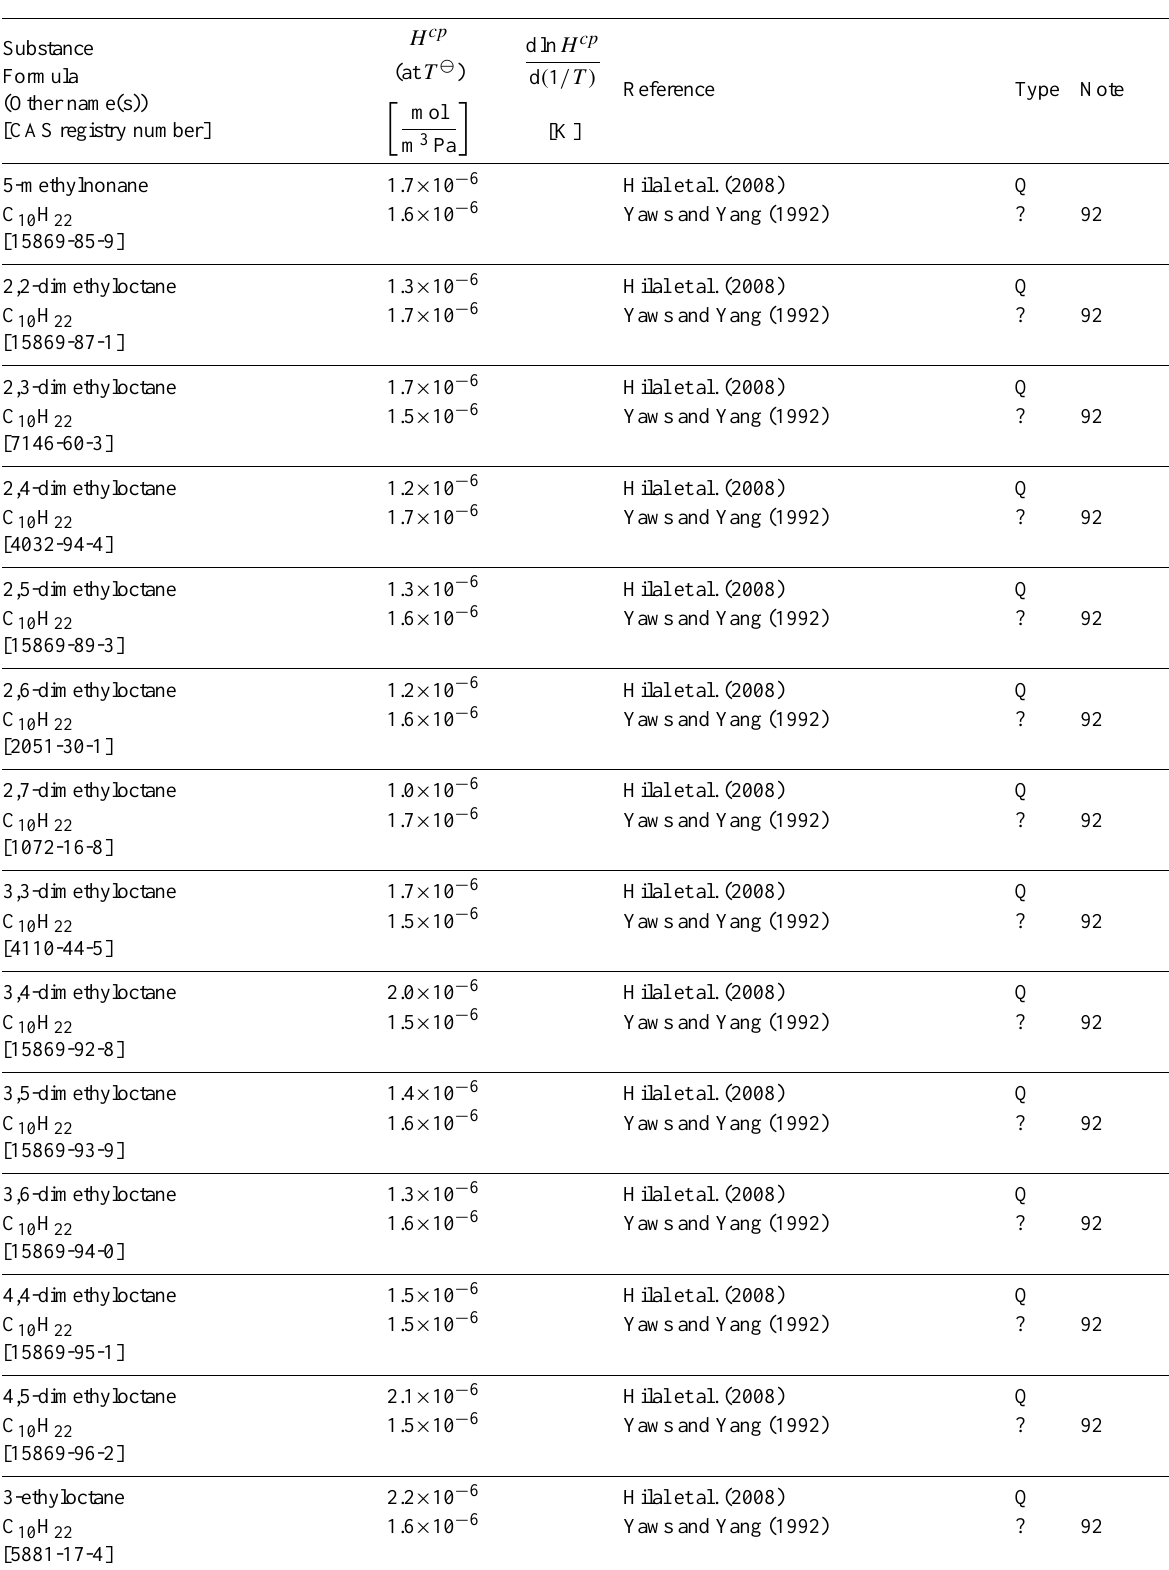
Table 6: Henry’s law constants for water as solvent